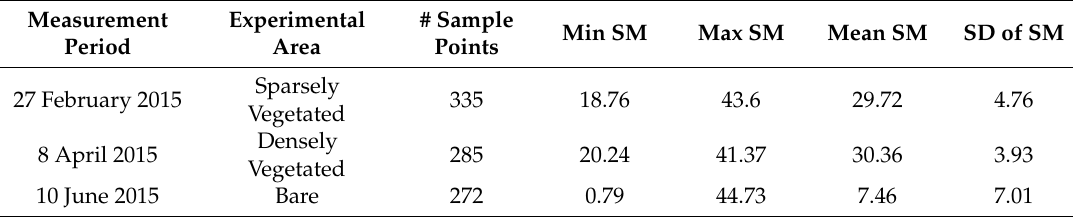
Table 1. General information about gravimetrical soil moisture